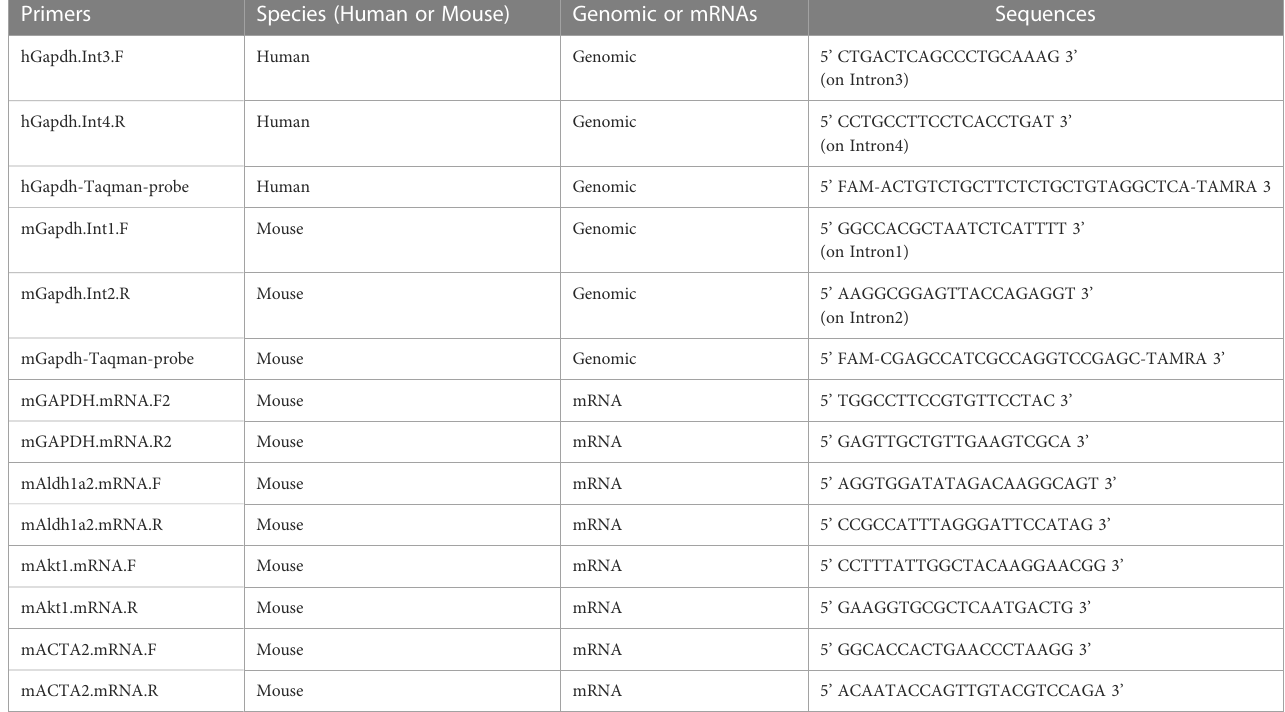
TABLE 2 Primers used in this